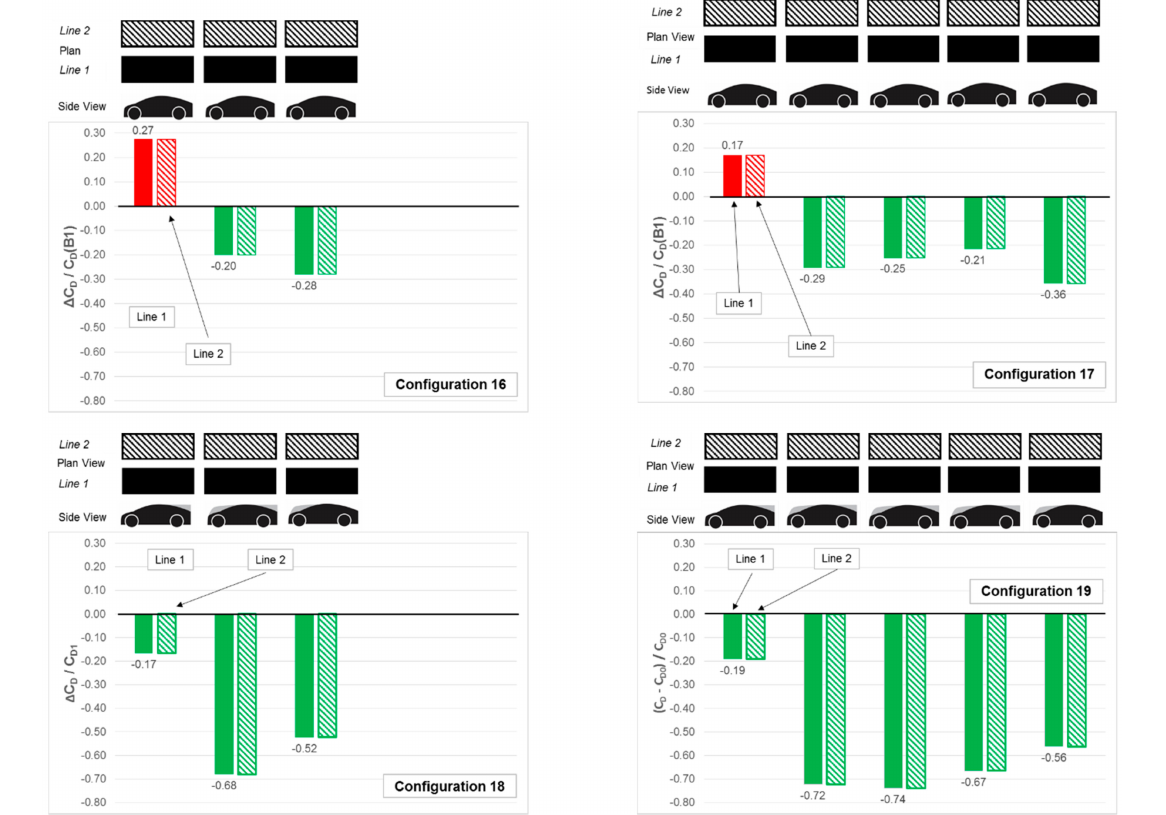
Figure 10. Twin-Line configurations consisting of platoons 3-model and 5-model homogeneous B1-style models (Configura- tions 16 and 17), and also suitable combinations of B2, B3, and B4-styled models (Configurations 18 and 19).